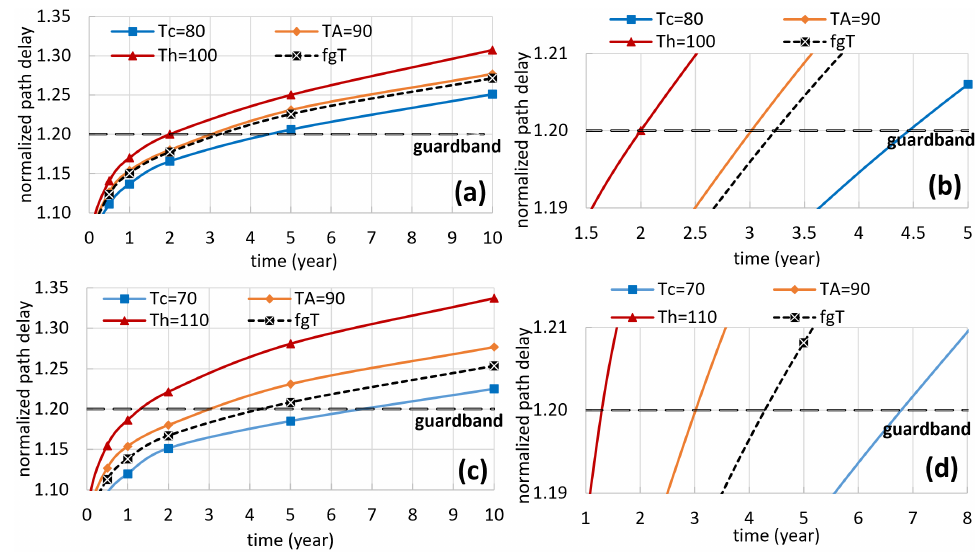
Figure 11. Ethernet longest path delay for various DTM constraints: ( a ) T c = 80 ◦ C, T h = 100 ◦ C; ( b ) T c = 80 ◦ C, T h = 100 ◦ C zoom-in; ( c ) T c = 70 ◦ C, T h = 110 ◦ C ( d ) T c = 70 ◦ C, T h = 110 ◦ C